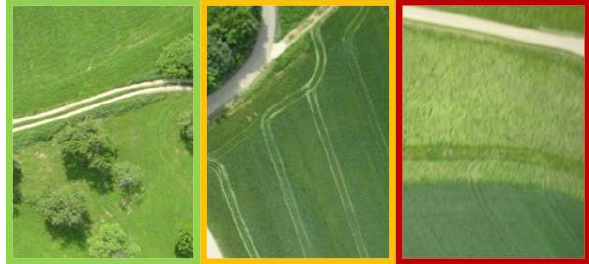
Figure 5: Three images patches with sharpness values. Left: low image blur (0.18, green), middle: moderate image blur (0.36 yellow) and high image blur (0.38, red).